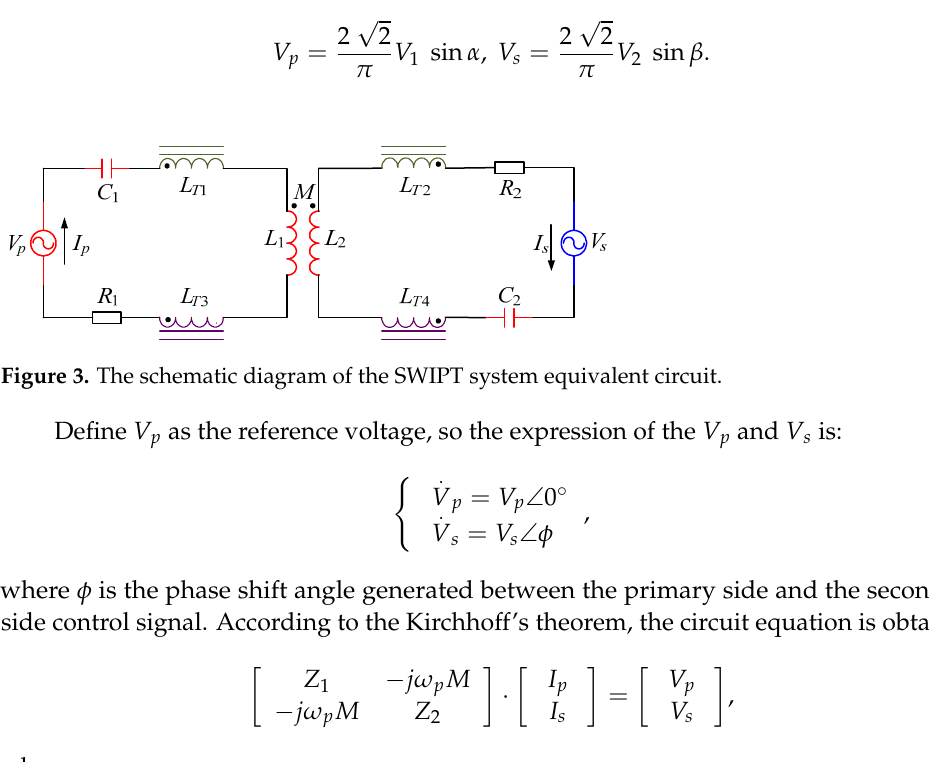
Figure 2. The timing diagram of phase shift control signals. The equivalent circuit model of the proposed SWIPT system is presented in Figure 3, where L T 1 ~ L T 4 are the equivalent inductance of the tightly coupled transformer. During power transfer, the impedance of the tightly coupled transformer inductor L T 1 ~ L T 4 are much smaller than the reflected impedance of information demodulation cells. V p and V s are the primary and secondary inverter output voltage. In order to simplify analysis, only the amplitude of fundamental frequency component is retained and higher harmonics are ignored. Then V p and V s are equivalent to: